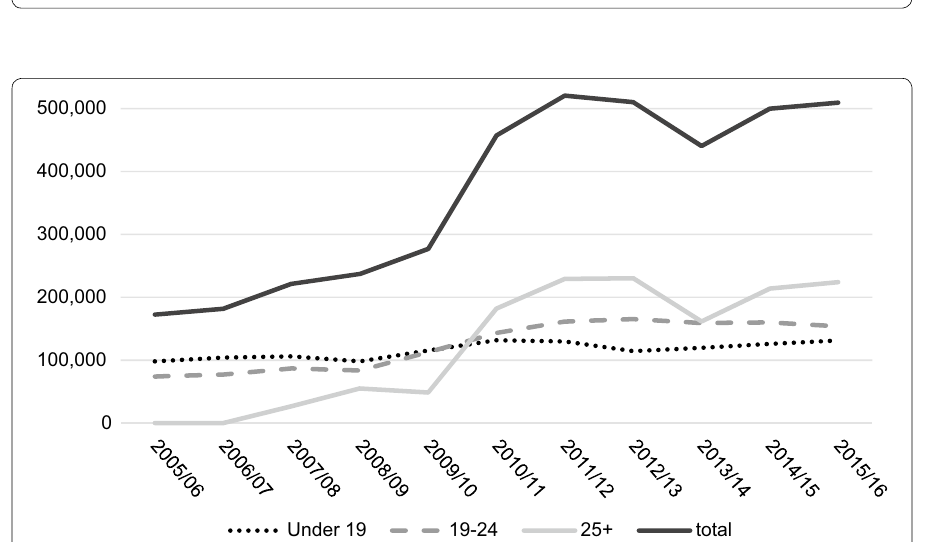
Fig. 3 Apprenticeship starts by age, 2005/06 to 2015/16 (Source: skills funding agency statistical first release apprenticeships starts by region, level and